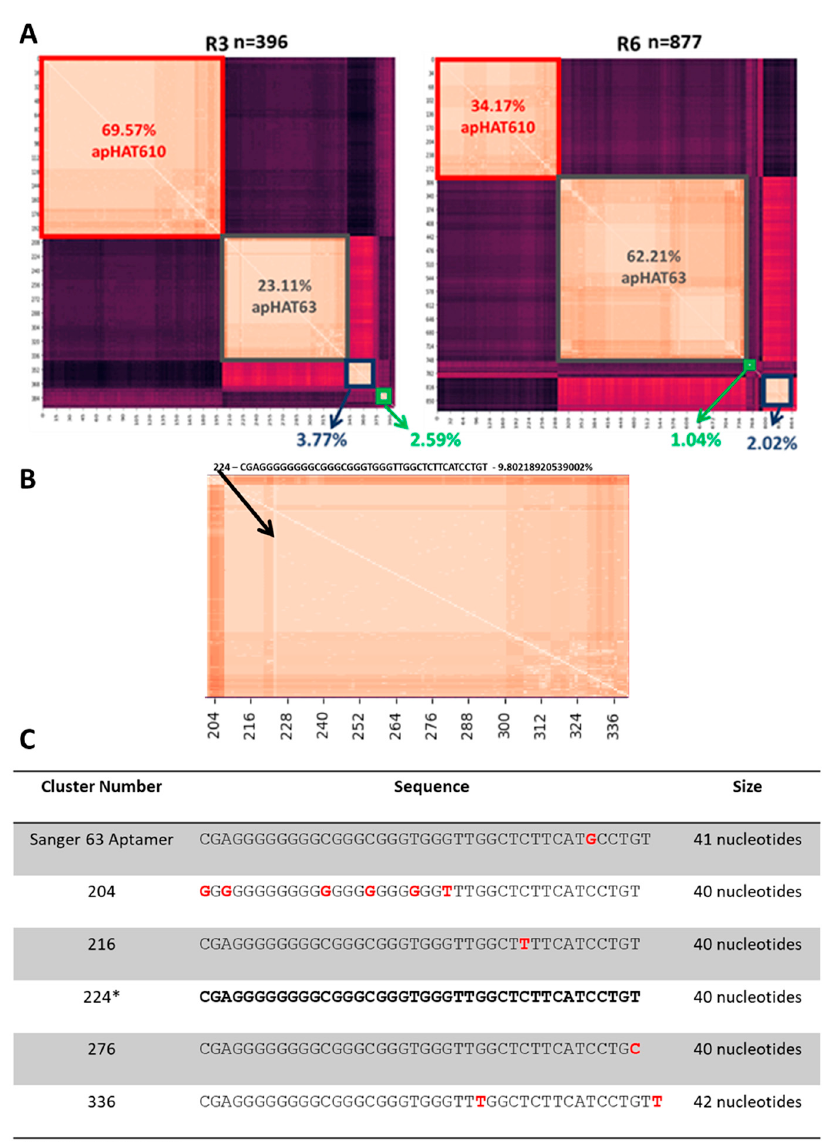
Figure 3. NGS analysis of rounds three and six of aptamer selection against HAT1. ( A ) Heat map of rounds three ( left ) and six ( right ) sequenced with NGS and analyzed with Phyton software according to their sequence similarity. Lighter colors indicate high similarity and darker colors indicate low similarity. The percentage of representation of each cluster was calculated by summing all of the percentages of representation of each sequence. Sequences in the red cluster correspond to apHAT610-like sequences, and sequences in the gray cluster correspond to apHAT63-like sequences that were seen in Sanger sequencing. ( B ) Representative example of the heat map of round three corresponding to the apHAT63 sequence cluster. The lighter color corresponds to the aptamer with the highest similarity to all other aptamers in this cluster. The arrow points to aptamer 224 and indicates the sequence with the lightest color in this cluster, which coincides with the most represented aptamer in the cluster. ( C ) Table showing four randomly chosen sequences representative of the cluster, in addition to the most represented sequence, which is marked with * and bold. The first row shows the sequence of the aptamer obtained by Sanger sequencing. Nucleotides in red indicate existing modifications compared to the most represented aptamer. The sequences shown correspond to the variable region of the aptamers. See also the phylogenetic dendrogram in Supplementary Figure